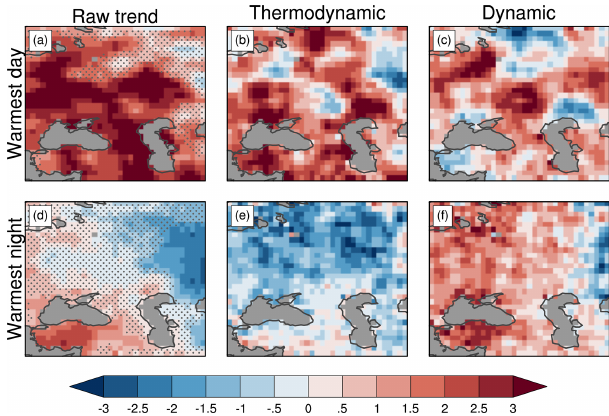
Figure 5. Summer temperature extremes: 1979–2018 trend maps for western Asia based on BERK (trend unit is degrees Celsius ev- ery 40 years, shading): (a–c) TXx raw trend and TXx thermody- namic and dynamic component trends. (d–f) TNx raw trend and TNx thermodynamic and dynamic component trends. The trend de- tection is estimated using the non-parametric Mann–Kendall test, and the linear trend slope is computed based on the Theil–Sen esti- mator. In (a, d) , stippling indicates locations where the raw trend is not significant at the 5% level.